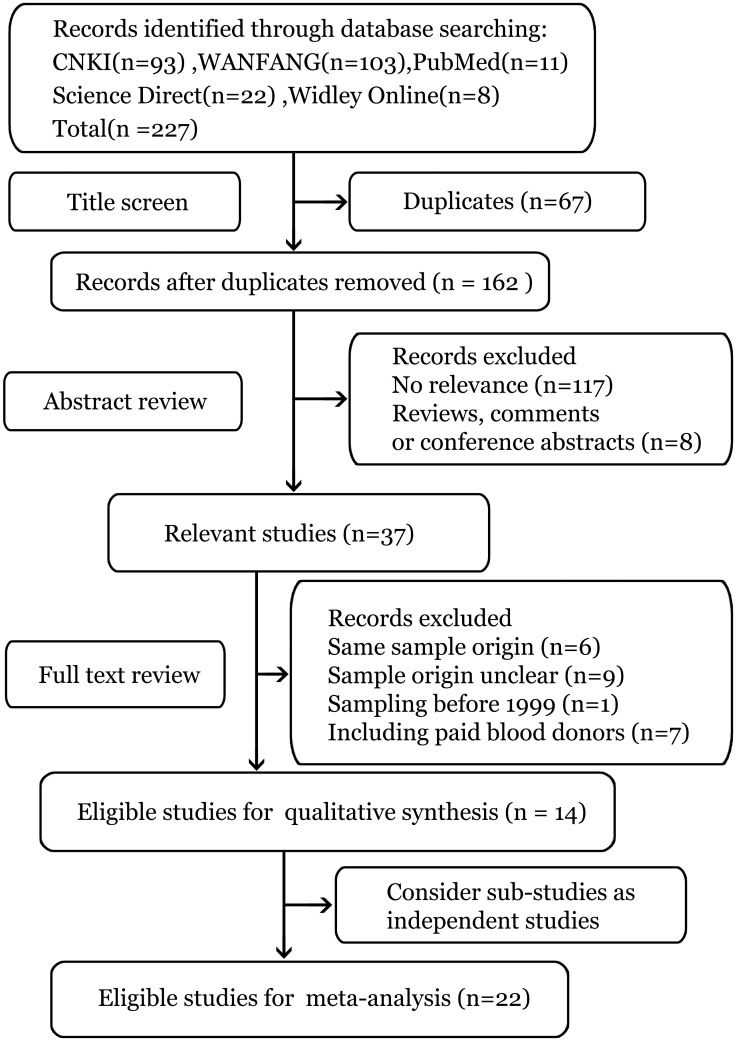
Flow chart of systematic literature search.